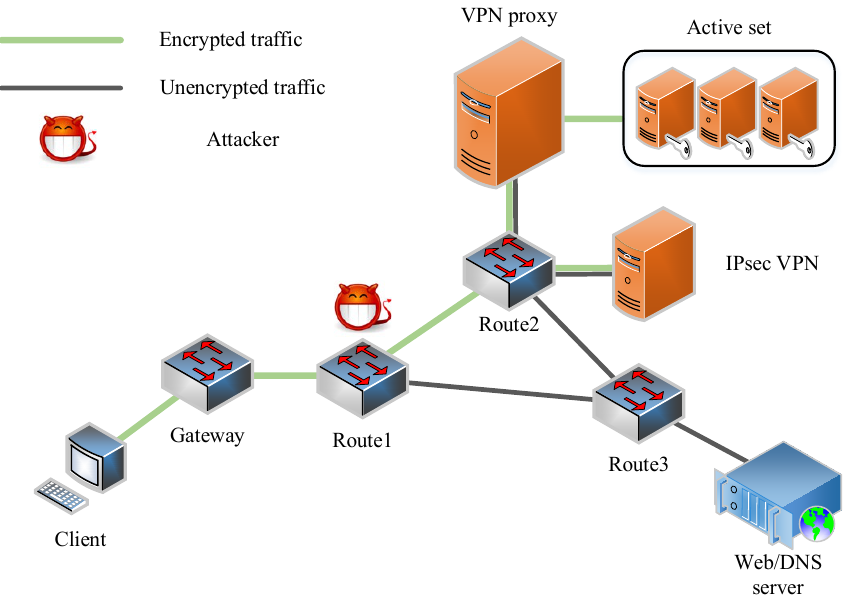
Figure 10. Description of virtual machine experiment environment.